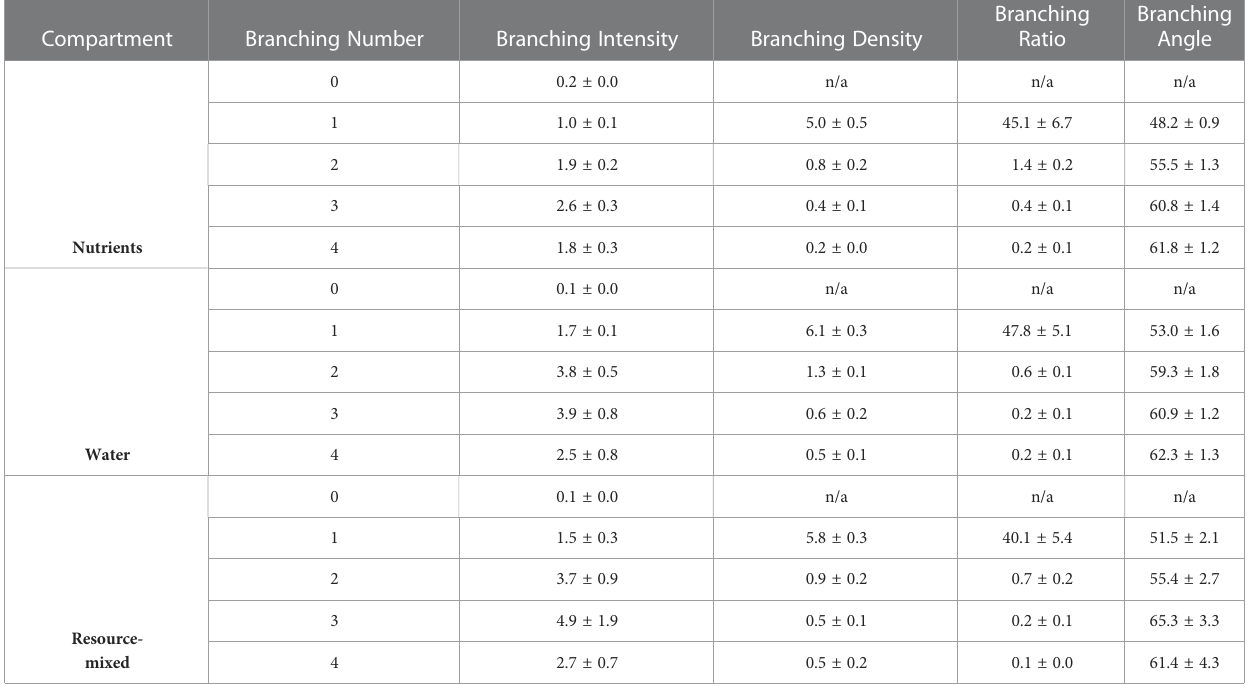
TABLE 1 Branching intensity (tips cm − 1 ), branching density (tips cm − 1 ), branching ratio (tips roots − 1 ), and lateral branching angles (degrees) by branching number of P. virgatum for roots growing in three compartment types (mean ± SEM).